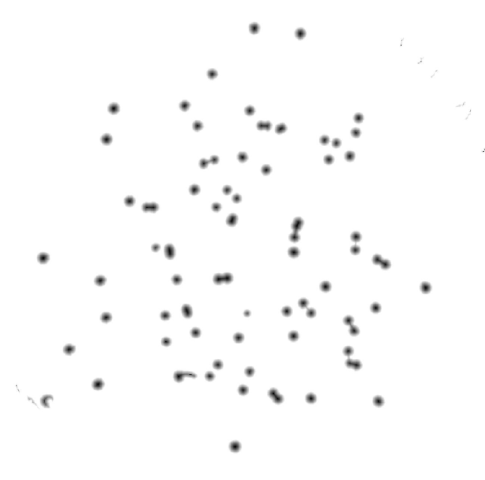
Figure 16. Minima imposition.